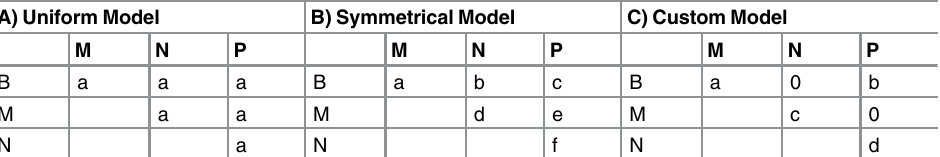
Table 3. Tested parental care strategy character transition